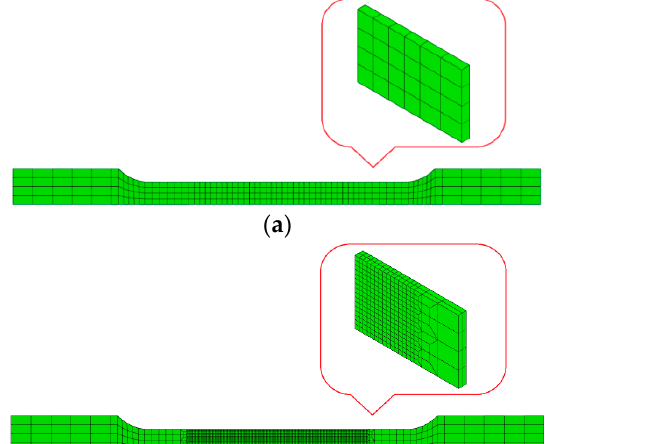
predicted deformed specimen, and ( b ) experimental uniaxial tensile test load elongation and predicted